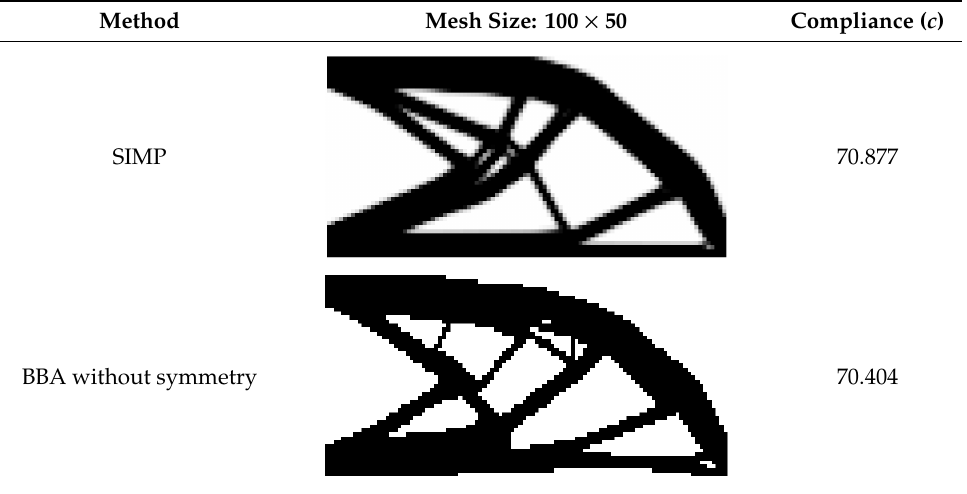
Table 2. Comparison of the best topologies of the cantilever plate (case 2).